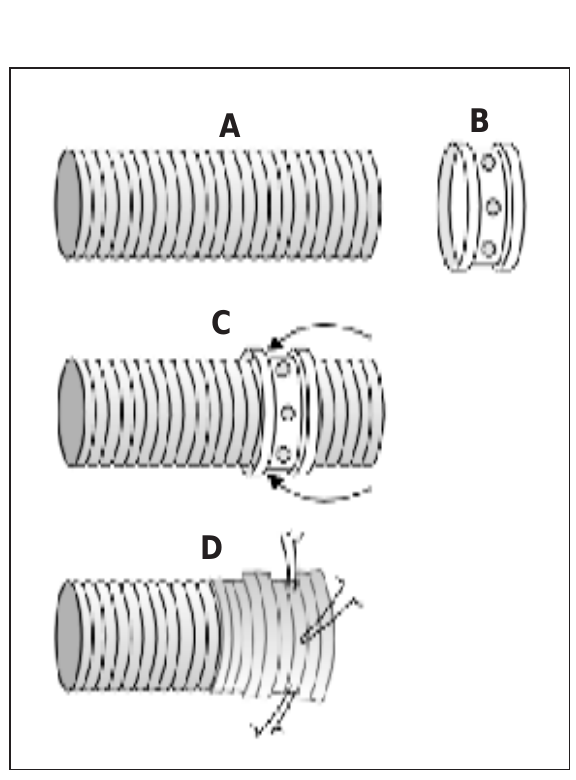
Fig. 2 - Preparo da prótese para fixação intraluminal sem sutura.